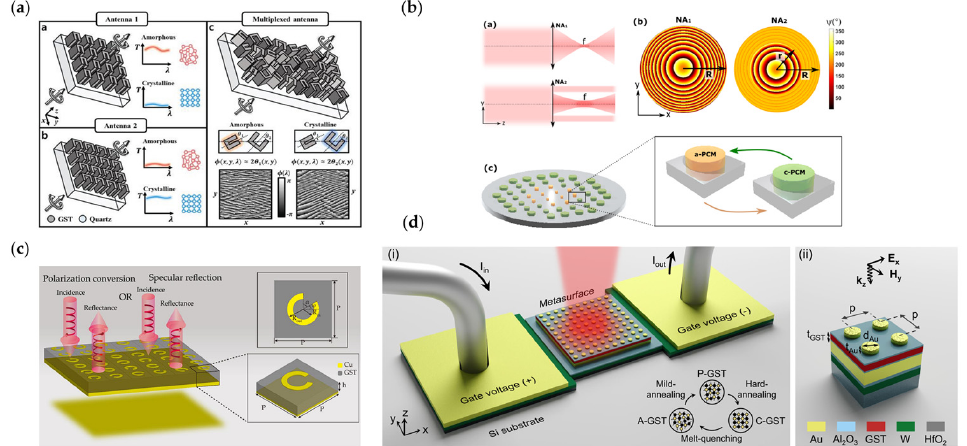
Figure 3. ( a ) Metasurface loaded with GST material realizing beam steering and holography by reconfiguring two complementary nano-antennas. Reprinted with permission from [167] , copyright© 2000–2023 by John Wiley and Sons, Inc. or related companies. All rights reserved; ( b ) A metalens optical responses; ( d ) Reprogrammable metasurface by changing the crystallization fraction of GST.